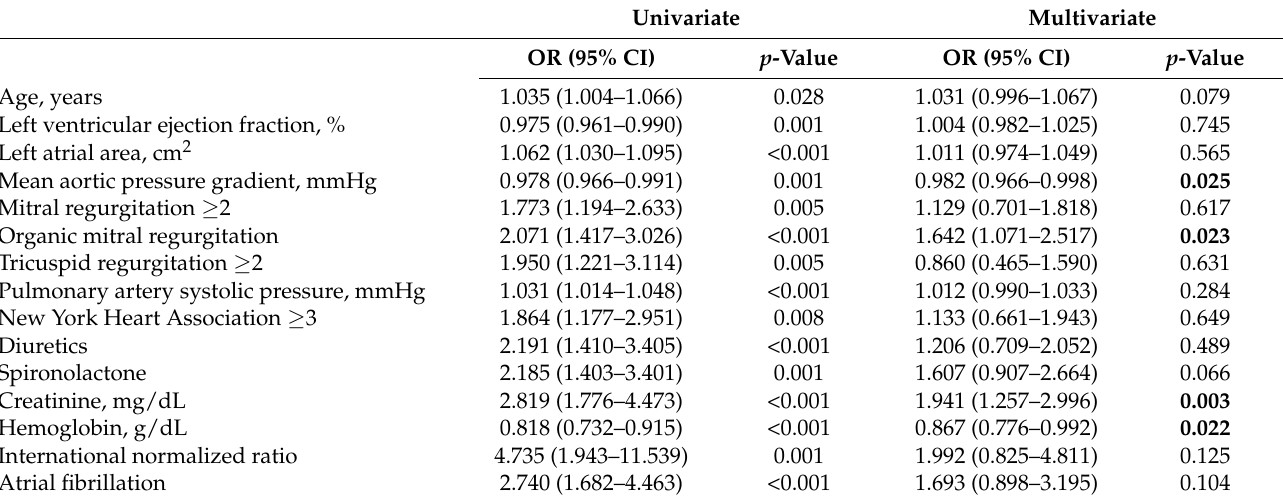
Table 2. Univariate and multivariate regression